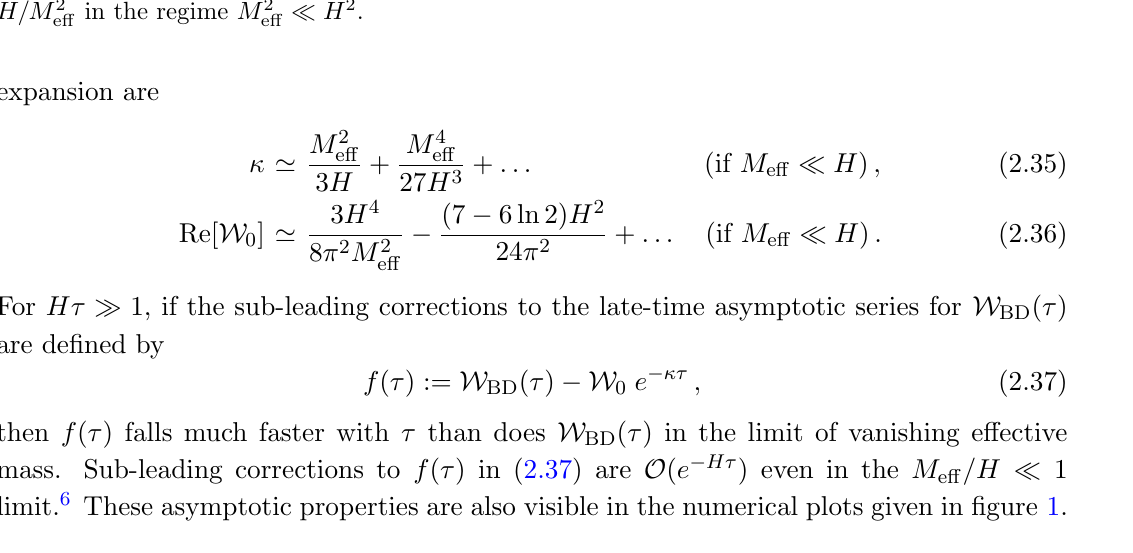
Figure 1 . A plot of Re[ W BD ] versus (cid:28) for various values of M e(cid:11) =H . The oscillatory component visible for M e(cid:11) =H > 3 disappears once M e(cid:11) =H < 3 . The exponential damping occurs over a few 2 2 & 2 H 2 but becomes much longer as M Hubble times ( H (cid:0) 1 ) for M 2 e(cid:11) ! 0, becoming of order e(cid:11) H=M 2 in the regime M 2 (cid:28) H 2 e(cid:11) e(cid:11)